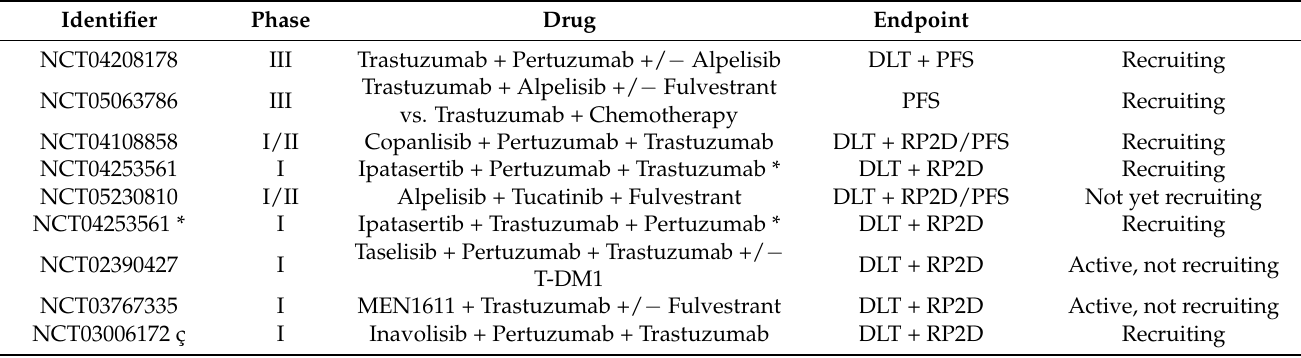
Table 3. Currently ongoing trials with